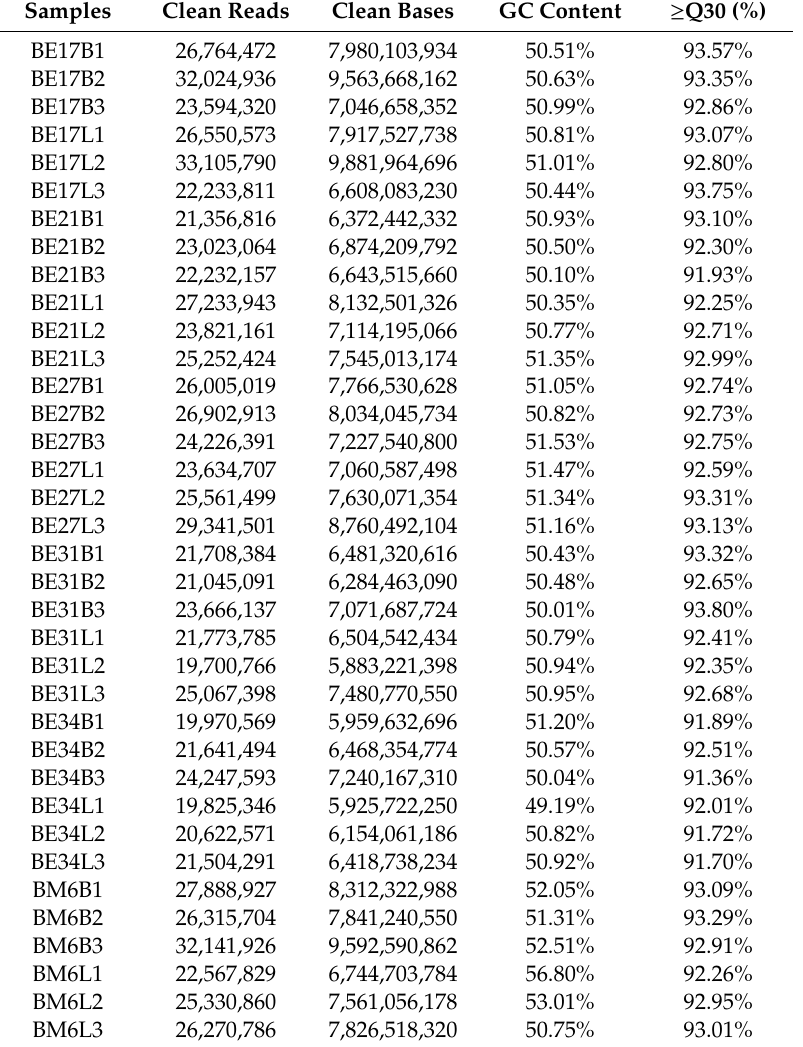
Table 3. RNA-Seq data from breast muscle and leg muscle of black Muscovy duck. Samples